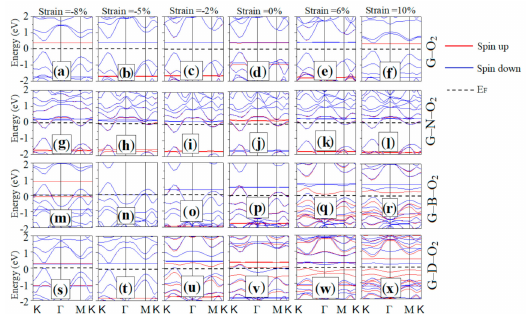
Figure 5. ( a – f ) Band structures for G–O 2 ; ( g–l ) G–N–O 2 ; ( m–r ) G–B–O 2 ; and ( s–x ) G–D–O 2 under equibiaxial strains. The figures from left to right columns correspond to the band structures calculated at the representative strains of − 8%, − 5%, − 2%, 0%, 6%, and 10% in turn. The red and blue lines represent spin-up and spin-down bands, respectively. The Fermi level is set to zero and indicated by the horizontal dashed